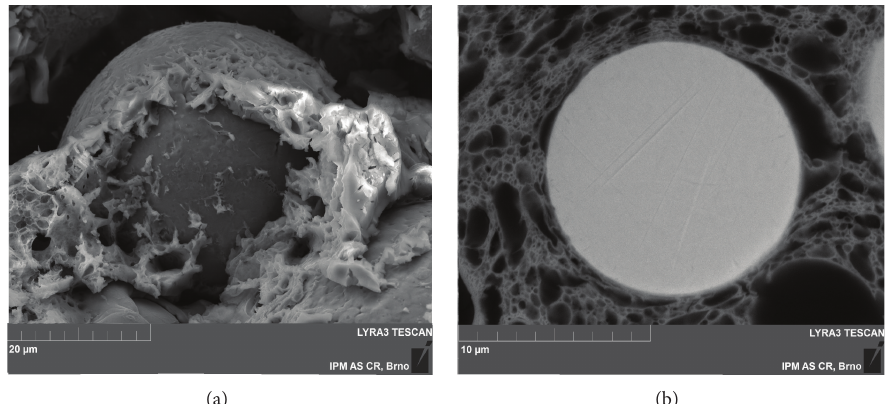
Figure 7: SEM images from (a) the individual FeSi particle covered by Mn 0.8 Zn 0.2 Fe 2 O 4 ferrite; (b) the cross section of FeSi particle surrounded by Mn 0.8 Zn 0.2 Fe 2 O 4 ferrite.